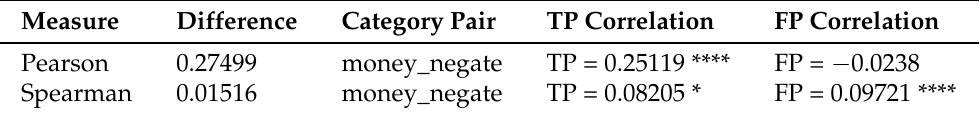
Table 51. Money and Negations in